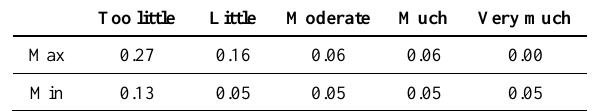
Table 9. Determining the ideal positive solution and the ideal negative solution.